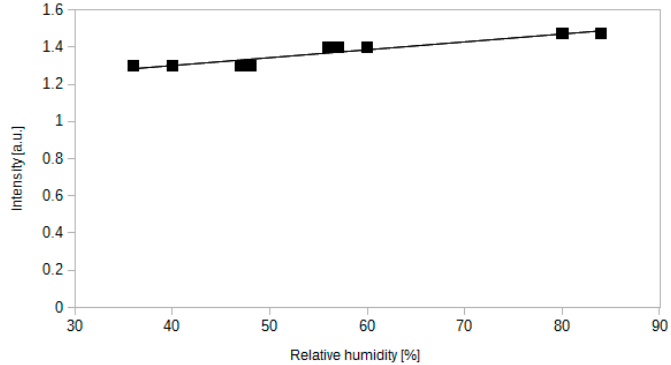
Figure 12. Dependence between relative humidity and the intensity of transmitted light. The measurements were carried out at 18 °C with a sensor containing methyl red.